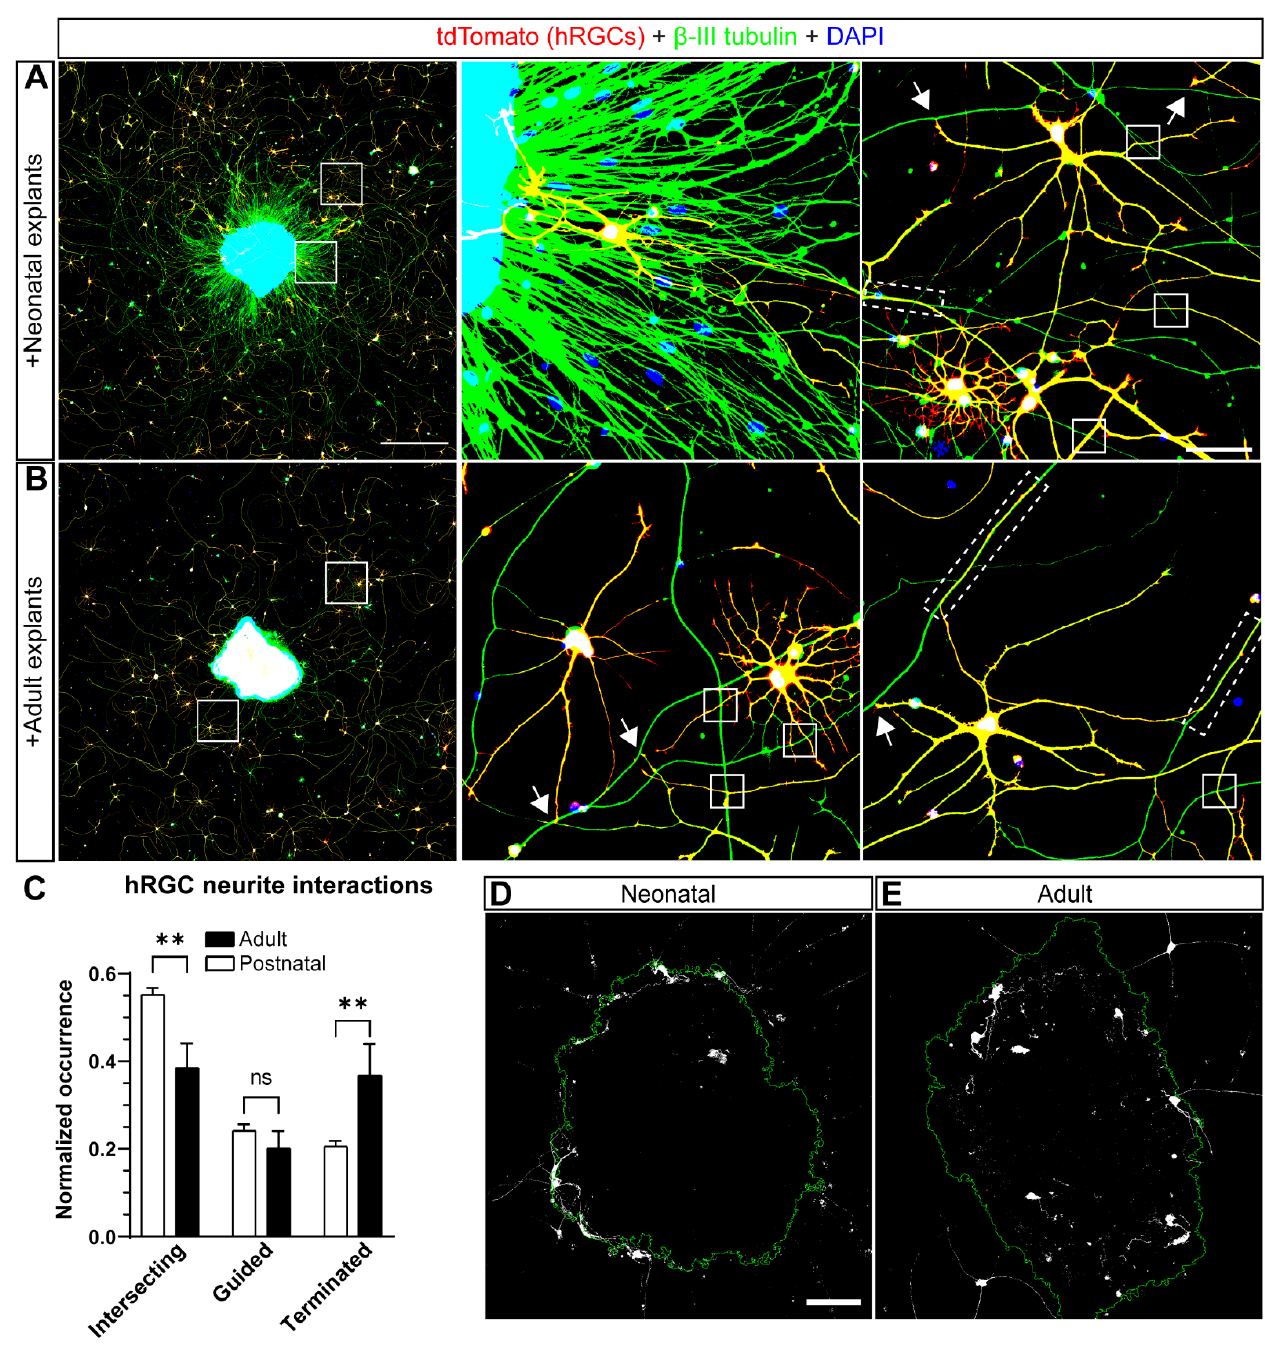
Figure 1. Interactions between hRGCs and mouse retina explants of neonatal and adult age. hRGCs were cocultured for 6 days with either neonatal (P5) or adult (P38) mouse retina explants ( A , B ). Cultures were immunostained with an anti-RFP antibody to amplify the tdTomato signal from hRGCs, β -III tubulin to label neurites and DAPI to label nuclei. Middle and right panels show magnified views of the boxes in the left panels. White arrows: examples of hRGC seemingly stalling in proximity to mouse RGC axons (terminated); white squares: examples of hRGCs seemingly disre- garding mouse RGC axons (intersecting); white dashed rectangles: hRGC neurites extending upon mouse axons (guided). ( C ) Quantification of the interactions between hRGC primary neurites and mouse RGC axons. The occurrence of hRGC primary neurites intersecting with mouse RGC axons is greater with neonatal explants ( p = 0.0065). The occurrence of guided events does not differ sig- nificantly between neonatal and adult cocultures ( p = 0.8349). The occurrence of terminated events is greater in the presence of adult explants ( p = 0.0085) ( D , E ) Representative maximum Z projections of confocal images showing the localization of hRGC neurites and cell bodies within mouse retinal